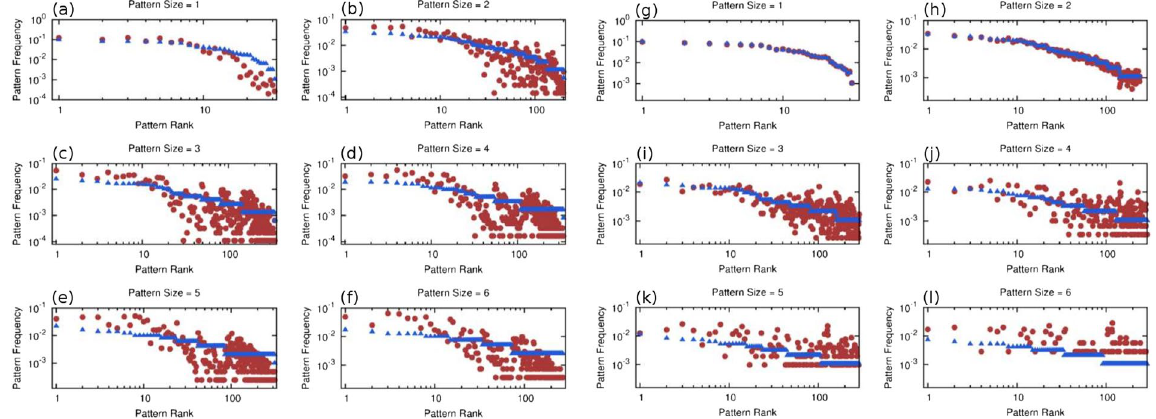
Figure 4. Frequency-rank plots for pattern frequencies. In blue, all patterns appearing in the corpus of sizes 1 to 6 are ranked according to their frequency. Here the corpus is the Bach Partita used previously (see Section S3 of the SI). Then, the same patterns are located in a N = 15000 sequence generated from the Maximum Entropy model ( a–f ) and a first-order Markov model ( g – l ). In red we plot their frequencies in the generated sequence but using the same order as before in order to compare with the corresponding frequencies in the corpus. For the Markov model, note that there is a good agreement for small patterns and worse for large ones. Note also that for the larger patterns (especially for size = 6) much fewer corpus patterns were found in the generated sequence, i.e. there are fewer red points than in the corresponding Maximum Entropy